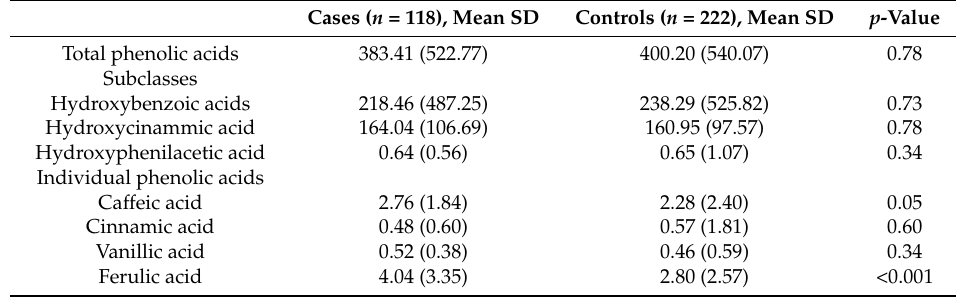
Table 2. Differences of mean total, subclasses and individual phenolic acids between cases and controls.